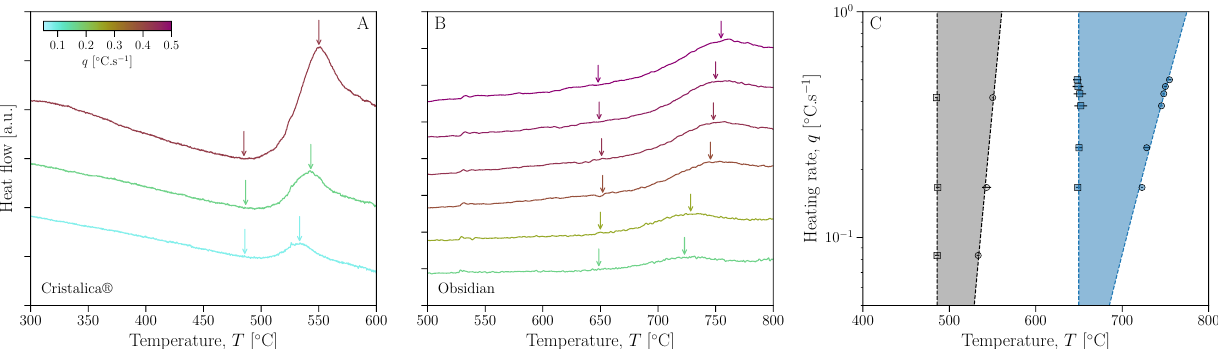
Figure 2: Structural relaxation of [A] synthetic Cristalica® glass used by glass artists, and [B] natural obsidian from Hrafntinnuhryggur, Krafla, Iceland, measured by differential scanning calorimetry at constant heating rates, yielding temperature-dependent heat flow curves (see text). In [A] the curves are for 3 heating rates: 0.08, 0.167, and 0.42 °C s − 1 ; in [B] the curves are for 6 heating rates: from 0.167 up to 0.467 °C s − 1 . The arrows denote the onset and peak (from left to right) of the glass transition interval, where the onset is measured as the first deviation from a linear baseline [see Gottsmann et al. 2002]. [C] The window between the onset and peak of the glass transition interval for Cristalica® (grey) and obsidian (blue). Note that the temperature position of the peak is heating rate